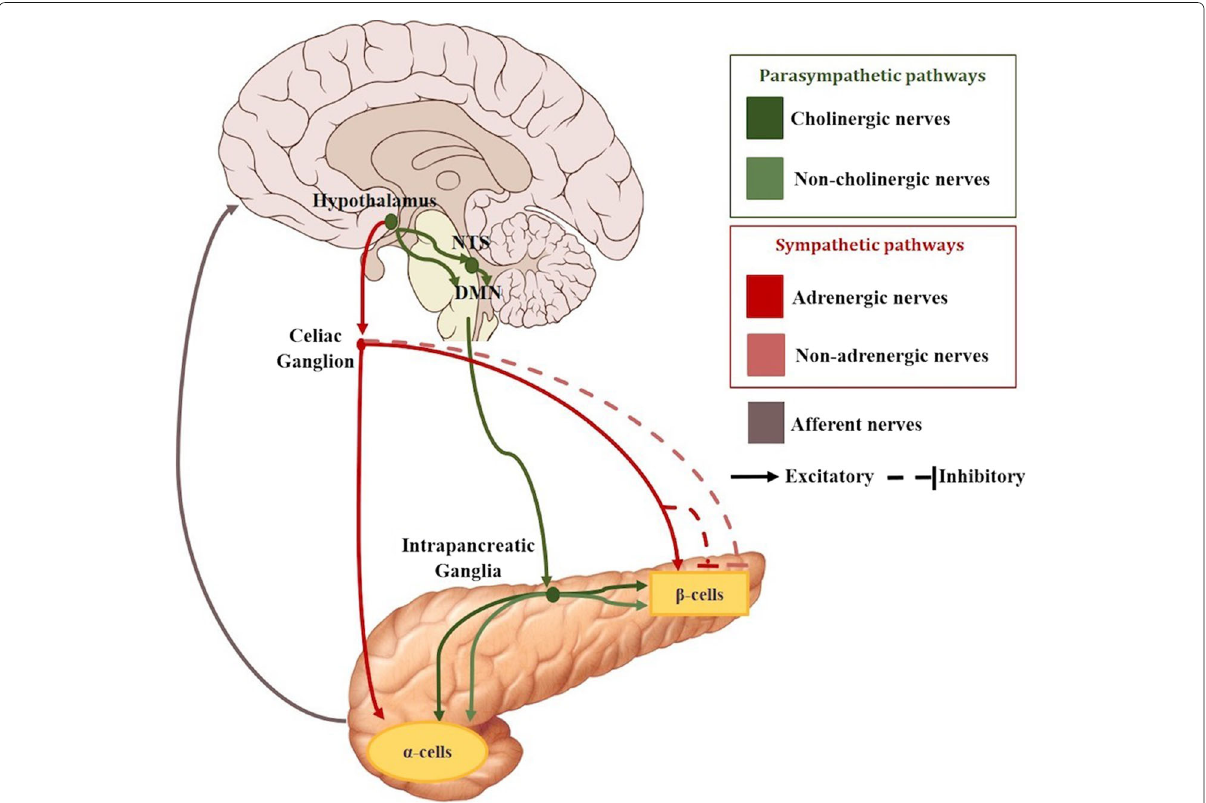
Fig. 2 Schematic of the most significant neural connections between the brain and the pancreas. The neural pathways to the α and β cells include postganglionic parasympathetic (green color range) and sympathetic (red color range) nerves. Afferent connections from the pancreas to the brain are also depicted